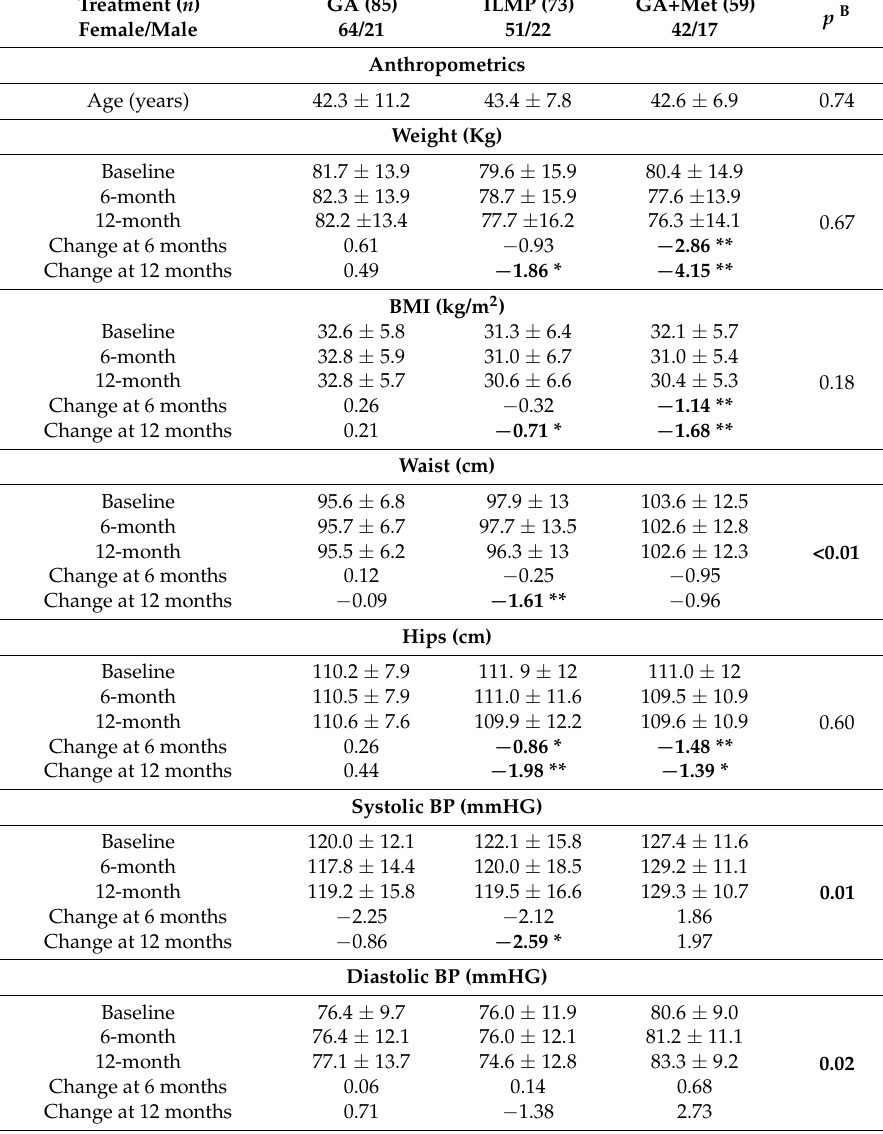
Table 1. Anthropometric and biochemical characteristics at baseline and follow-up. Treatment ( n )